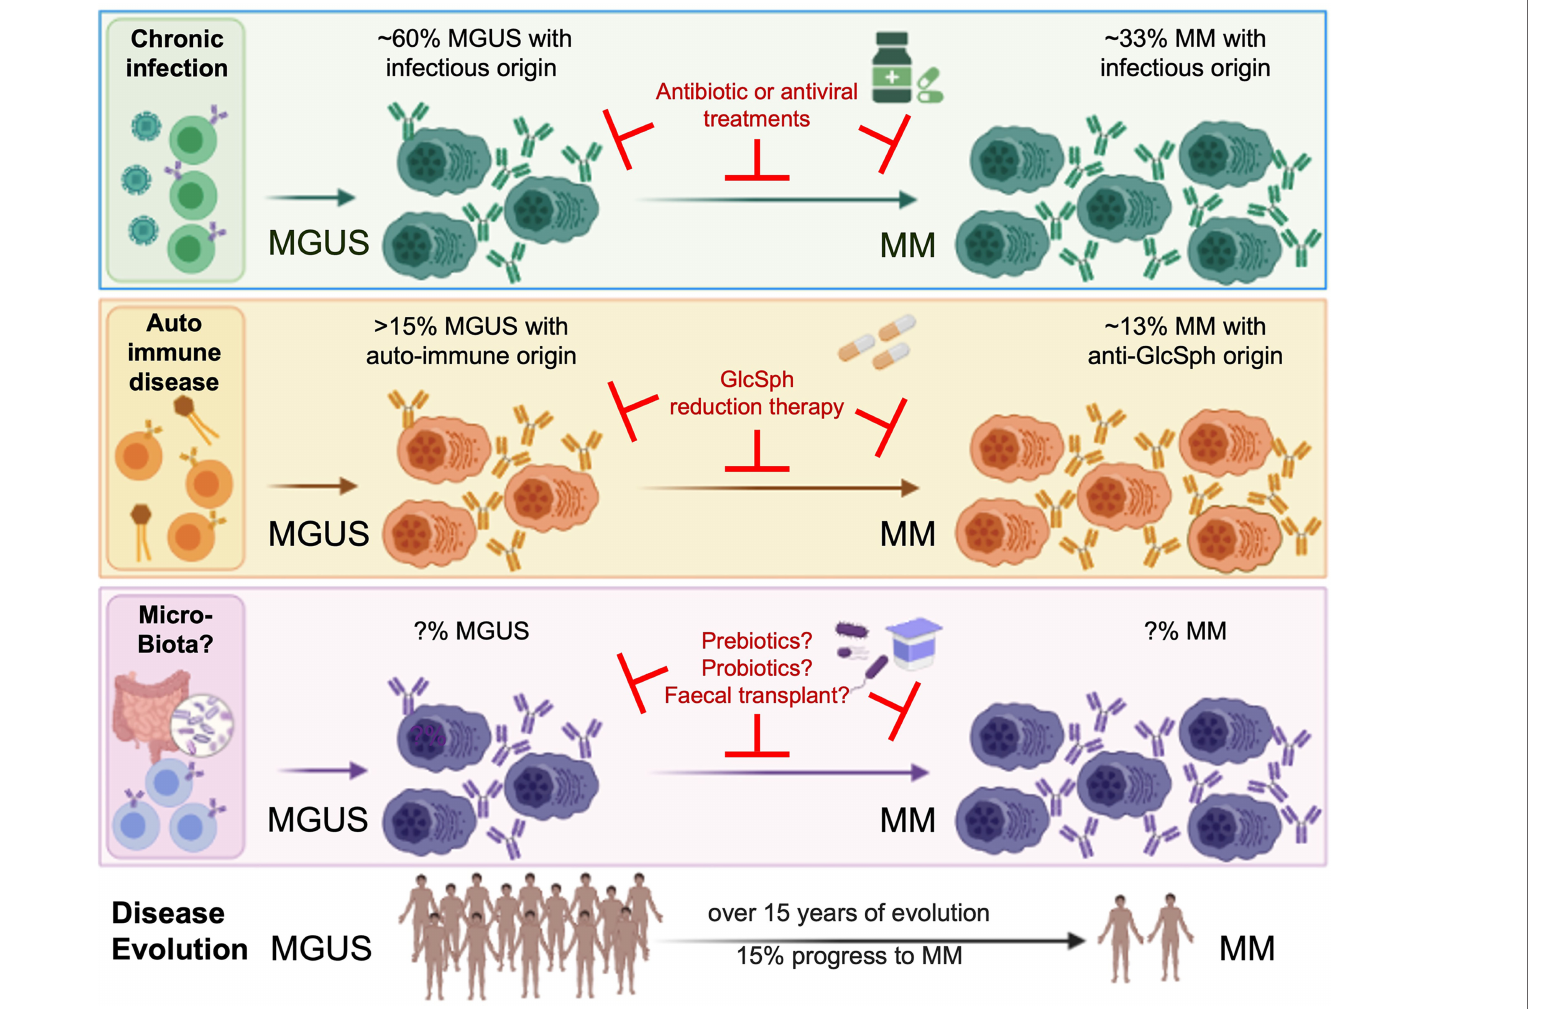
FIGURE 1 | Micro-organisms as initiating events in the pathogenesis of MGUS and MM, and interest for treatment. MM is always preceded by a MGUS stage, considered benign since only a fraction of MGUS eventually progress toward to overt MM. Although MGUS is most often asymptomatic, patients may present with renal, neurological or skin symptoms of various severity (for instance, monoclonal gammopathies of renal signi fi cance (MGRS)) (6 – 8). Associations between MGUS and autoimmune disorders, infection and recently, gut microbiota, are established (3, 5, 9, 10, 14 – 22). Importantly, several groups demonstrated that monoclonal Ig from MGUS and MM patients speci fi cally target either a self-antigen (including myelin-associated glycoprotein (MAG), glucosylsphingosine (GlcSph, in 13-15% MGUS/MM cases), other gangliosides, different membrane components) or an antigen from an infectious pathogen (including HCV, HBV, HIV, EBV, other Herpesviruses, Helicobacter pylori , or Enteroviruses, in 60% MGUS and 33% MM). That subsets of monoclonal Igs target antigens of the microbiota remains to be proven. Knowing the target of a patient ’ s monoclonal Ig is essential, for it allows to identify the likely initiating event of the disease, and to propose target antigen reduction therapy to patients. The ef fi cacy of this new therapeutic approach is proven for GlcSph-, HIV- and HCV-initiated monoclonal gammopathies (22, 33, Rodr ı ́ guez – Garc ı ́ a et al.), and deserves to be tested for MGUS and MM initiated by other treatable